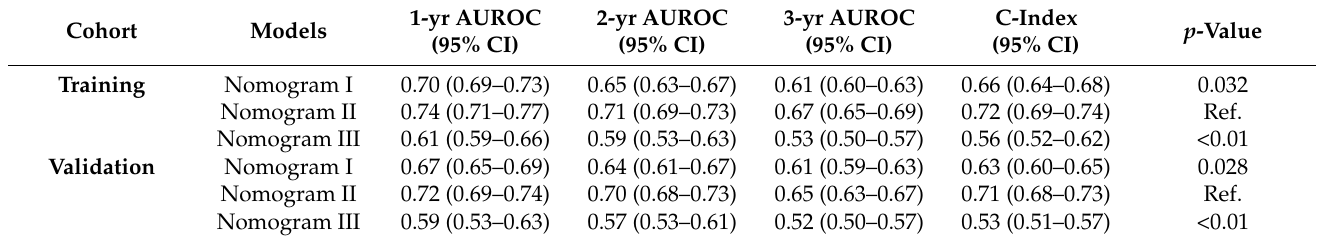
Table 5. Comparison of the performance and discriminative ability of constructed nomogram